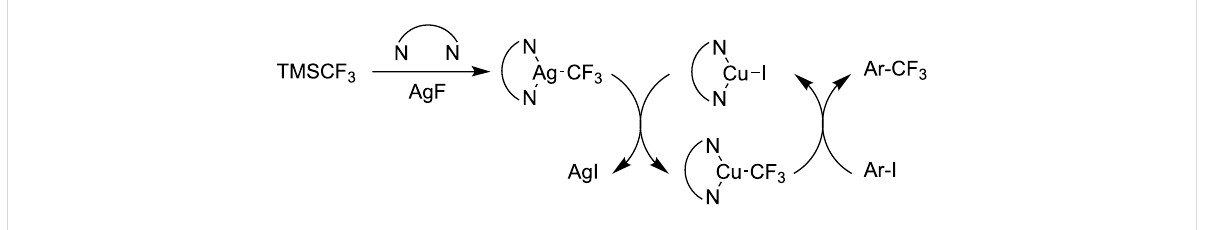
Figure 4: Postulated reaction pathway for the Ag/Cu-catalyzed trifluoromethylation of aryl iodides by Z. Q. Weng et al. [73].